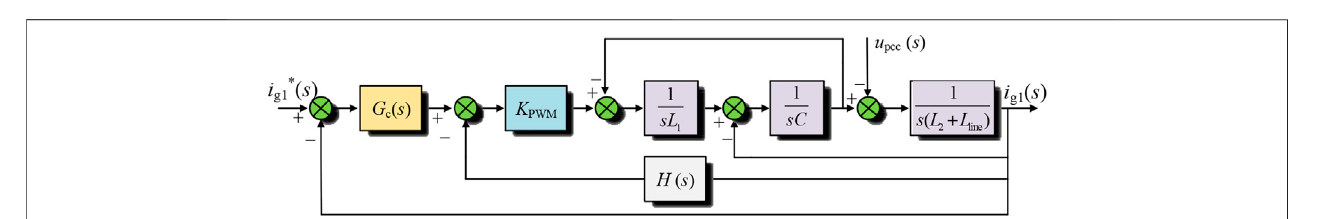
FIGURE 2 | Grid-connected current feedback control block diagram.